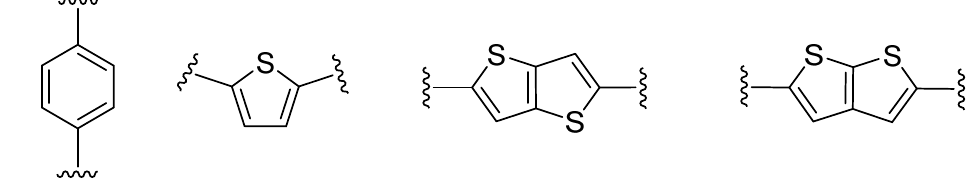
Figure 2. π -Linker examples commonly used in push–pull molecules.